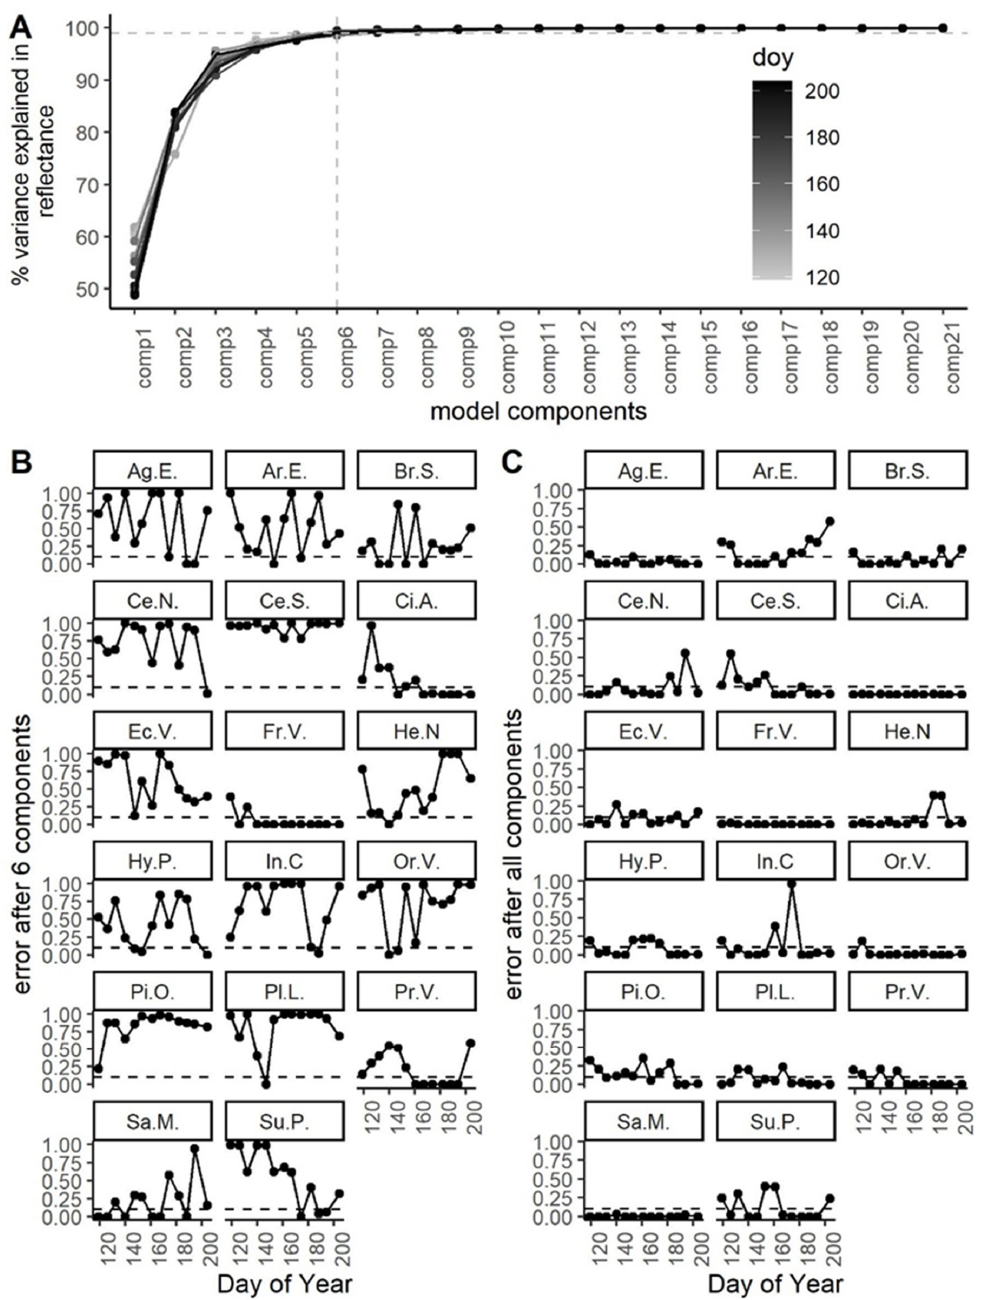
Figure 7. ( A ) The “scree plot” of the models at each time point, i.e., the variance in the X variable as explained by the model latent variables/components. The grey reference line represents the 99% variance in the X variable that was captured by six components, irrespective of sampling time; ( B ) species classification error over time with six components; ( C ) species classification error with the chosen number of components (i.e., the final model for each time point). Mean error is shown for each time point over the 10 model runs (the S.E. of the model runs was very small and is not shown). We used the number of components that were required to achieve a classification error of less than 0.1 as an indicator of the “ease of classification” for each species. The